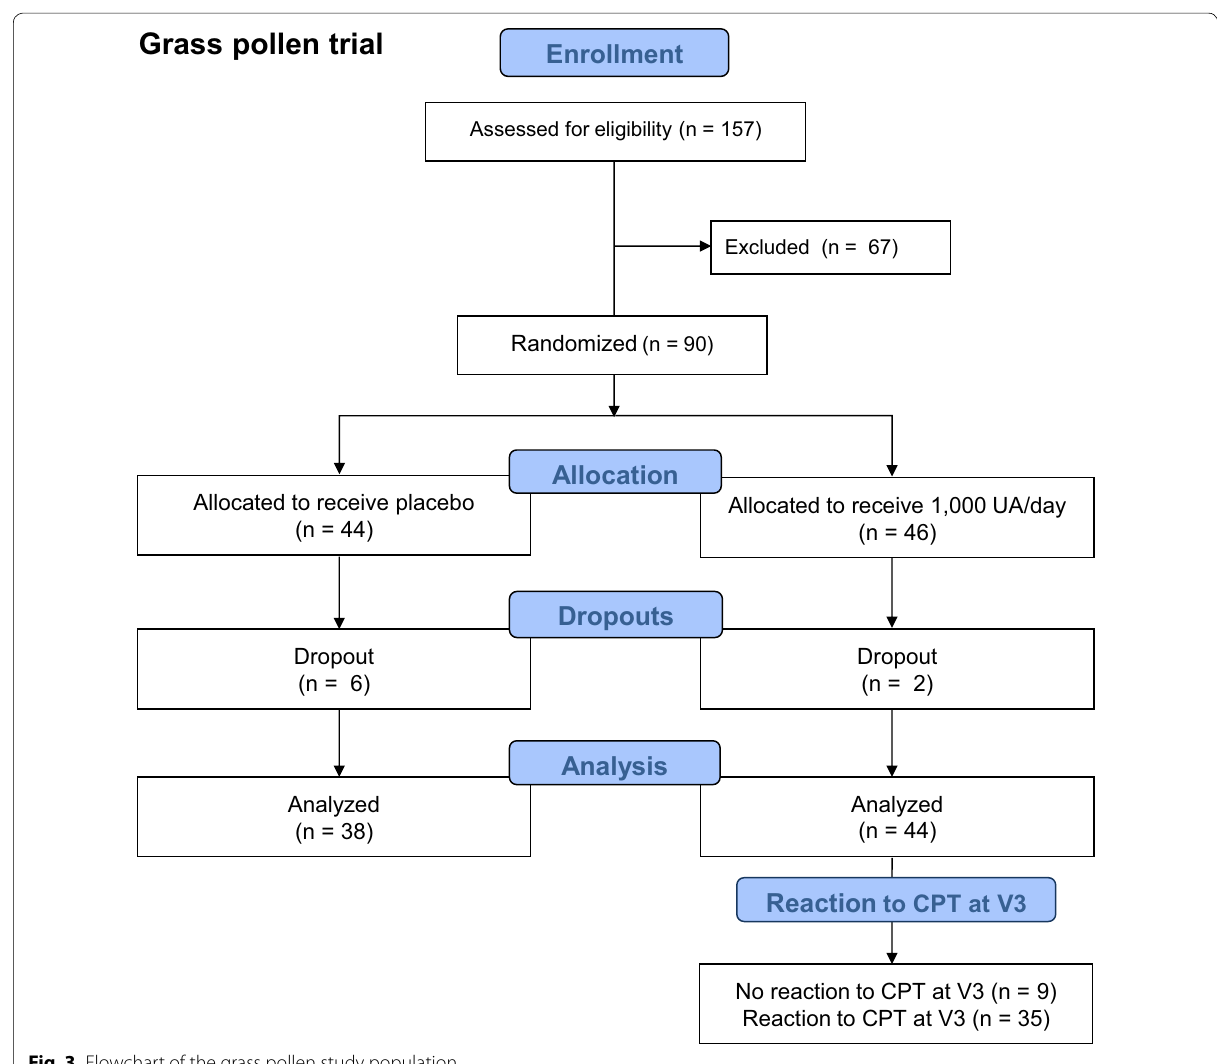
Fig. 3 Flowchart of the grass pollen study